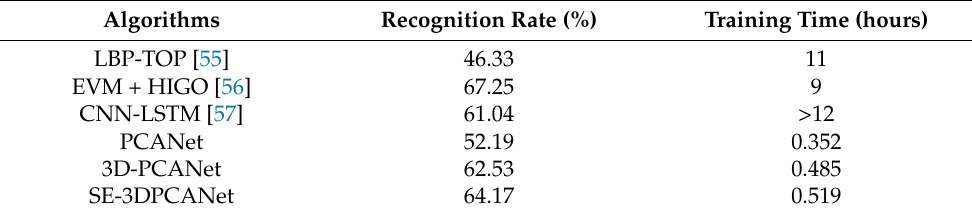
Table 3. Performance comparison of different algorithms on the CASME II